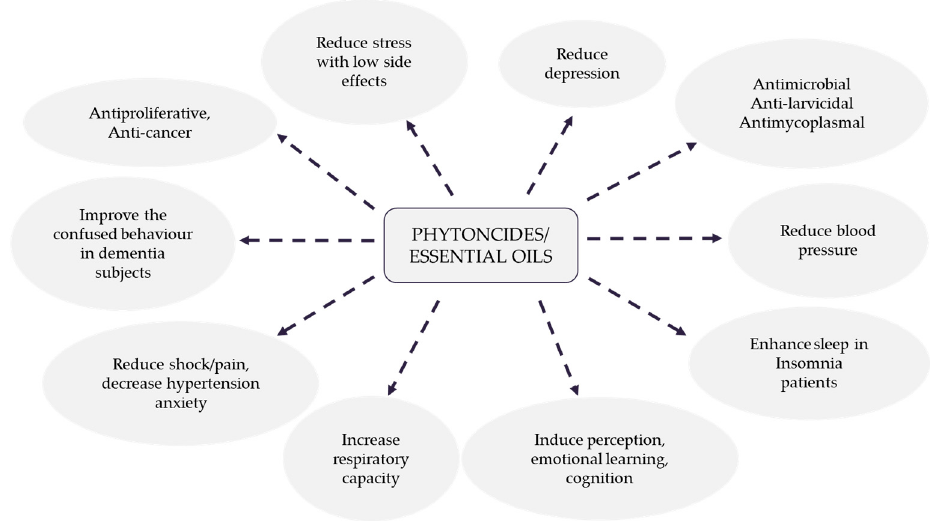
Figure 3. The beneficial effects of phytoncides/essential oils.